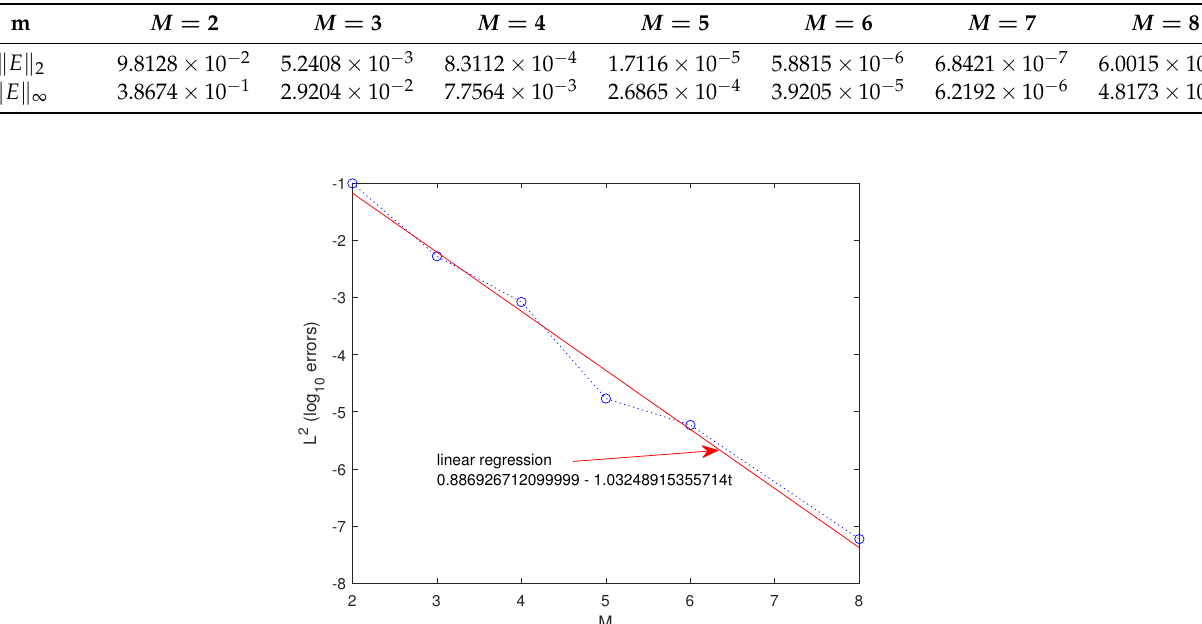
Table 5. The L ∞ and L 2 errors for Example 3.